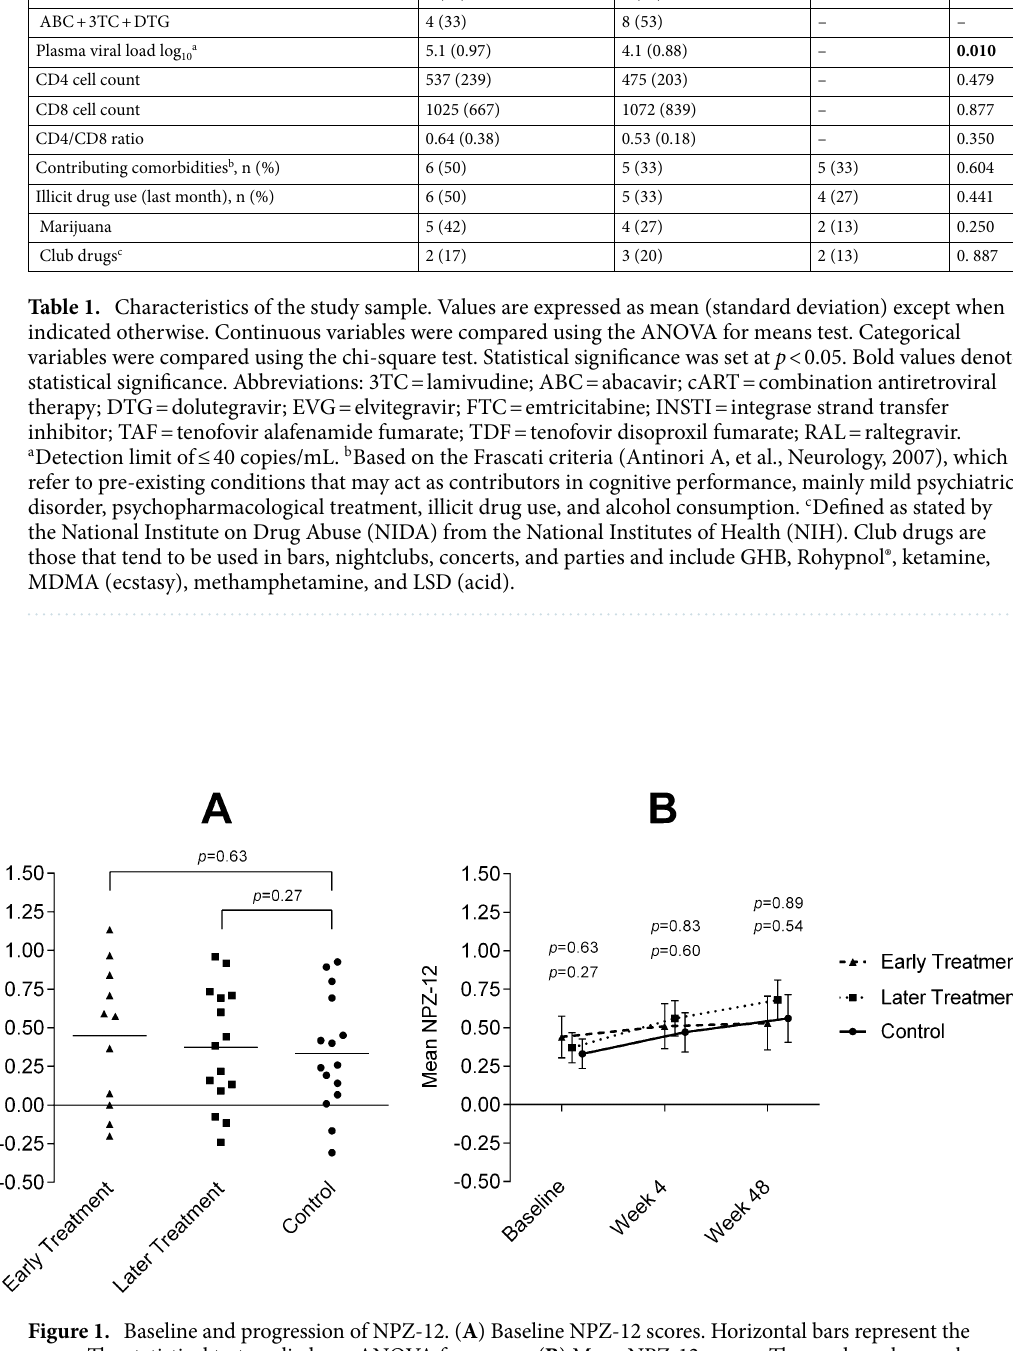
Figure 1. Baseline and progression of NPZ-12. ( A ) Baseline NPZ-12 scores. Horizontal bars represent the mean. The statistical test applied was ANOVA for means. ( B ) Mean NPZ-12 scores. The p values shown above indicate early treatment vs control comparisons. The p values shown below indicate later treatment vs control comparisons. The statistical test applied was ANOVA for